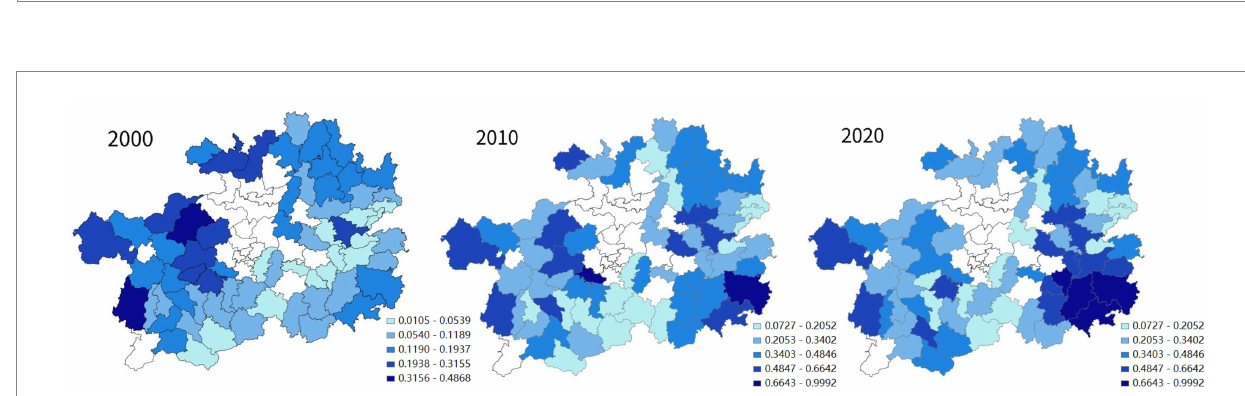
FIGURE 6 Spatial analysis of the changes in cultural QoL of Guizhou’s districts and counties.